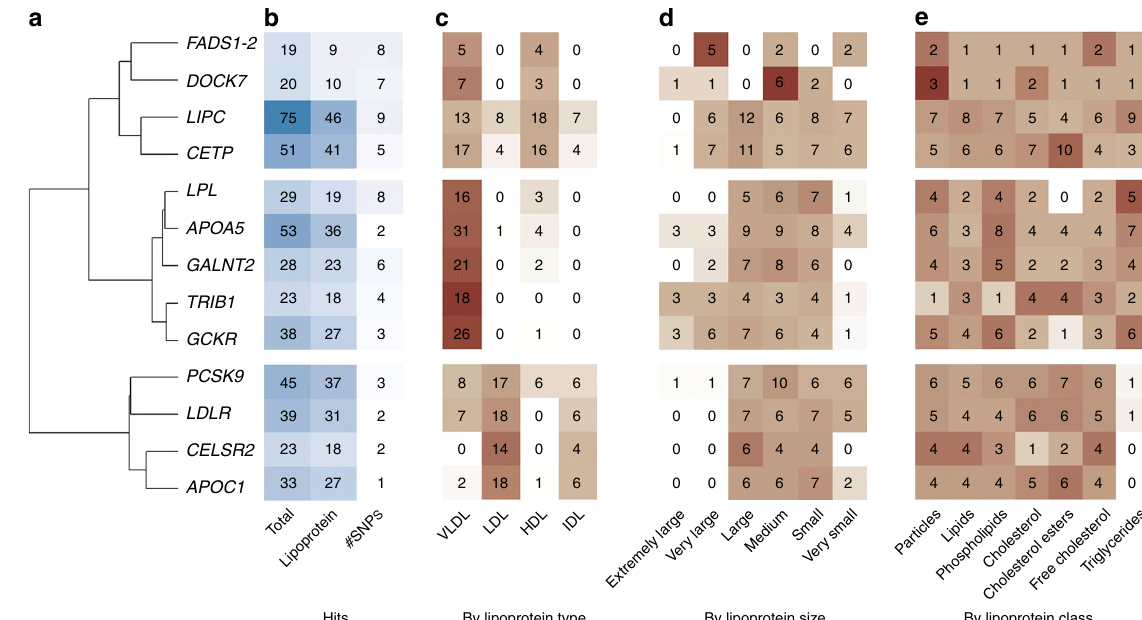
Fig. 4 Speci fi city of master regulators on lipoproteins. We performed a hierarchical clustering of the association between the 13 master regulators and the lipoprotein type ( a ). Further panels show the total number of associations, the number of associations with lipoprotein, and the total number of top associated SNP ( b ); the count of association hits by lipoprotein type ( c ), their size ( d ), and class ( e ). The background colors represent the relative proportion of association within each gene-item stratum, highlighting heterogeneity in the distribution of